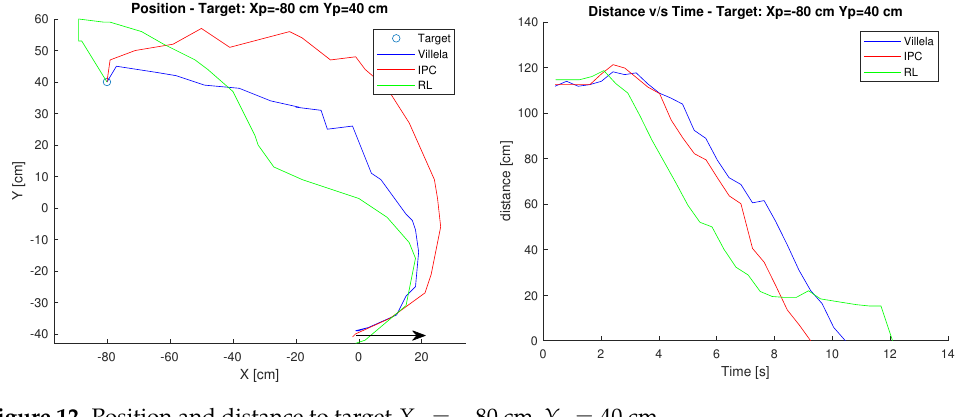
Figure 12. Position and distance to target X p = − 80 cm, Y p = 40